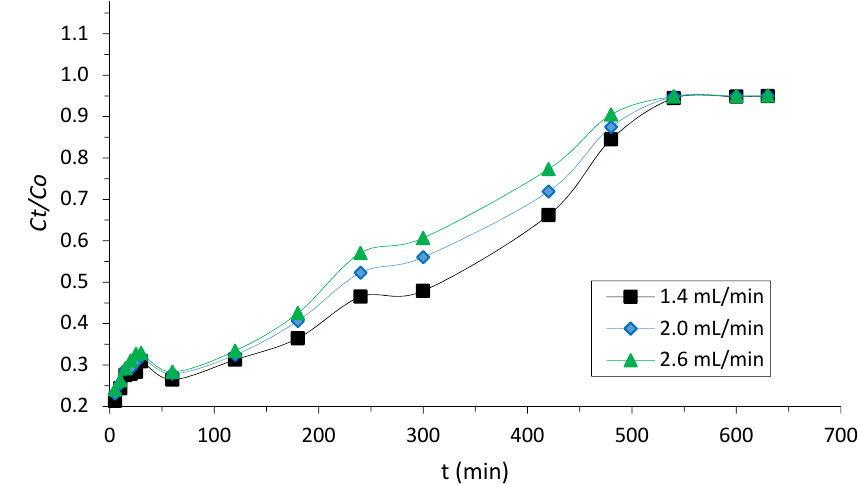
Figure 3. Breakthrough curve at different flow rate influent concentrations.